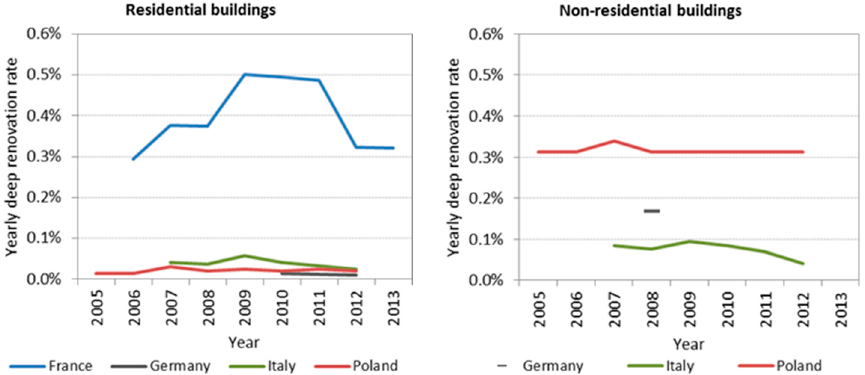
Figure 3. Evolution of deep renovation rates in some European Member States (in terms of % of the whole building stock renovated every year). Deep renovation means deep thermal renovation with more than two thermal solutions (e.g., heating plus insulation of wall/roof, etc.). Source: elaboration from